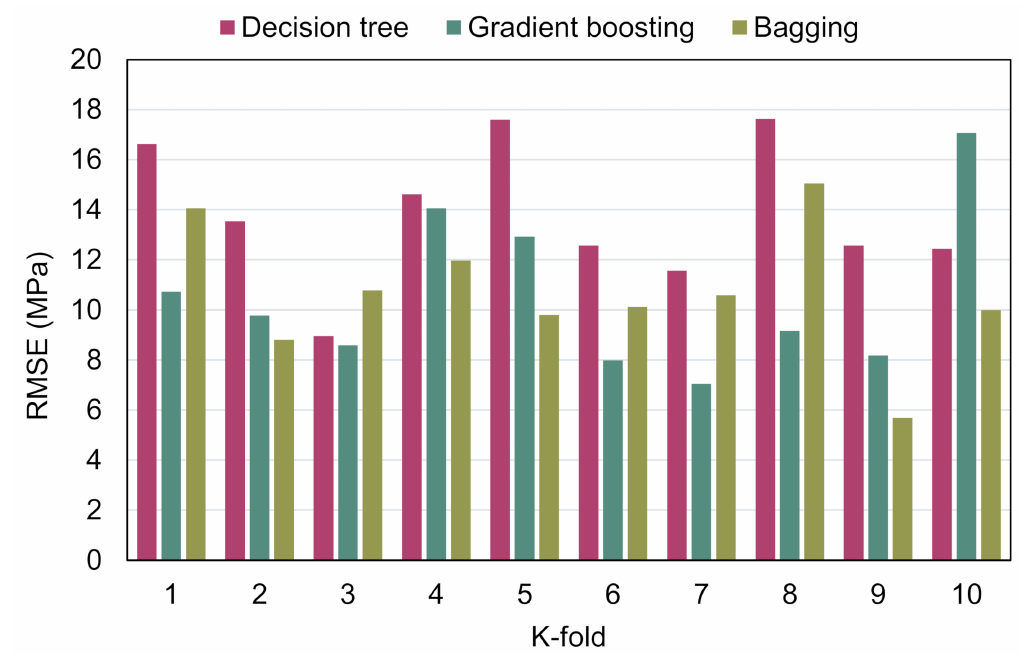
Figure 11. Root mean square error distribution from k-fold analysis.